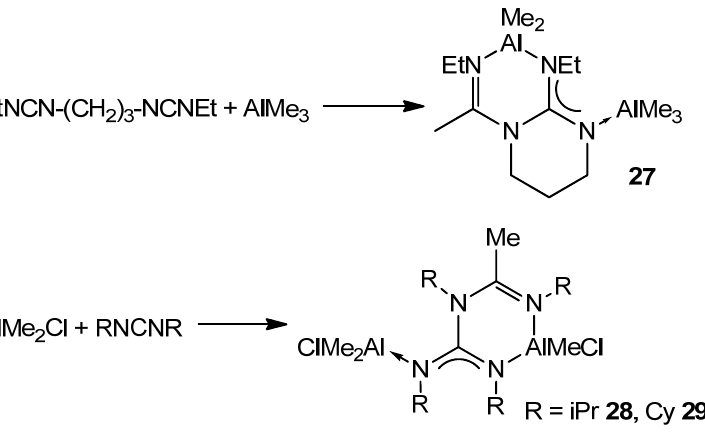
Figure 20. Double insertion of carbodiimides.